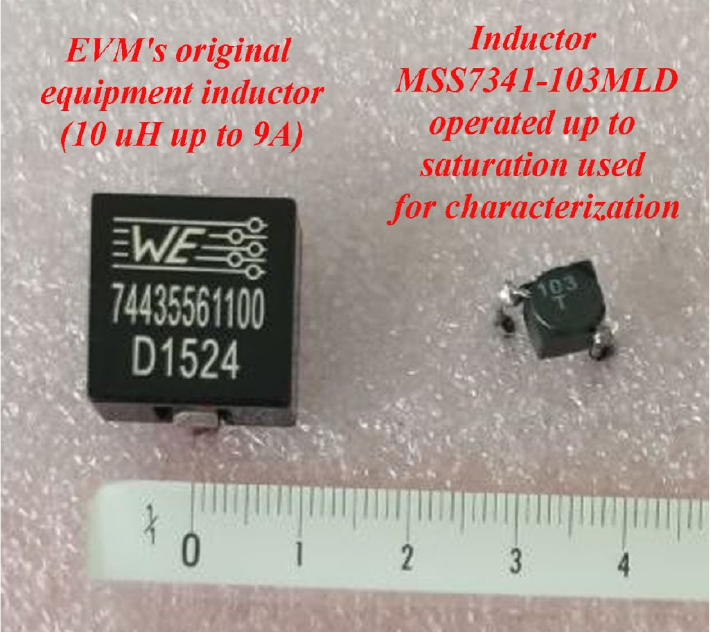
Figure 3. Comparison of the original inductor equipped on the EVM (left side) with the one applied in this paper (right side).